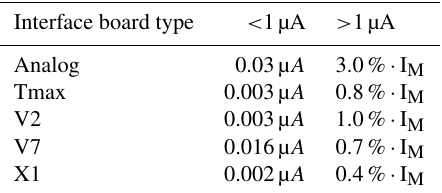
Table 4. Piece-wise functions for the relative uncertainty in the measured cell current of each interface board